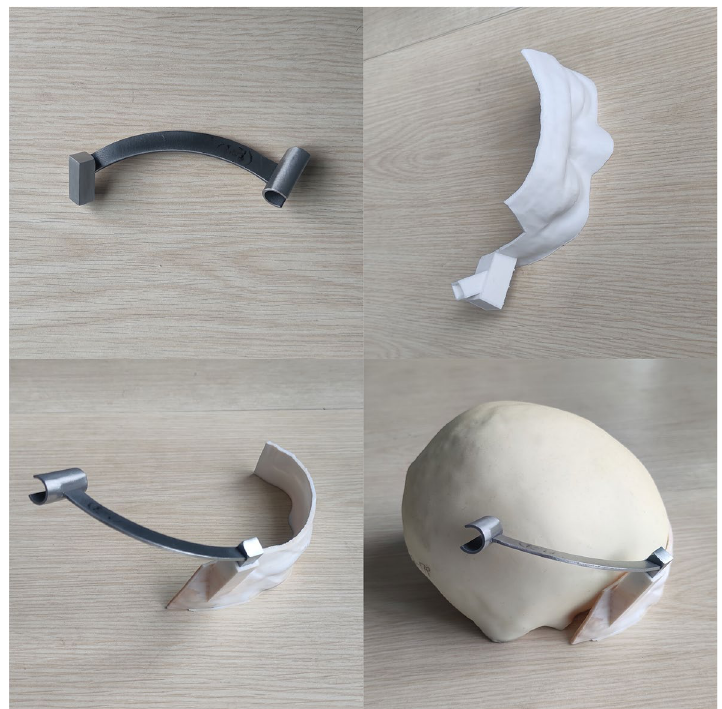
Figure 1. The metal guide plate can be used during operation after disinfection. Combined with the separately designed guide plate, it can guide the direction of intracranial lesions and the puncture direction of ventricular system during